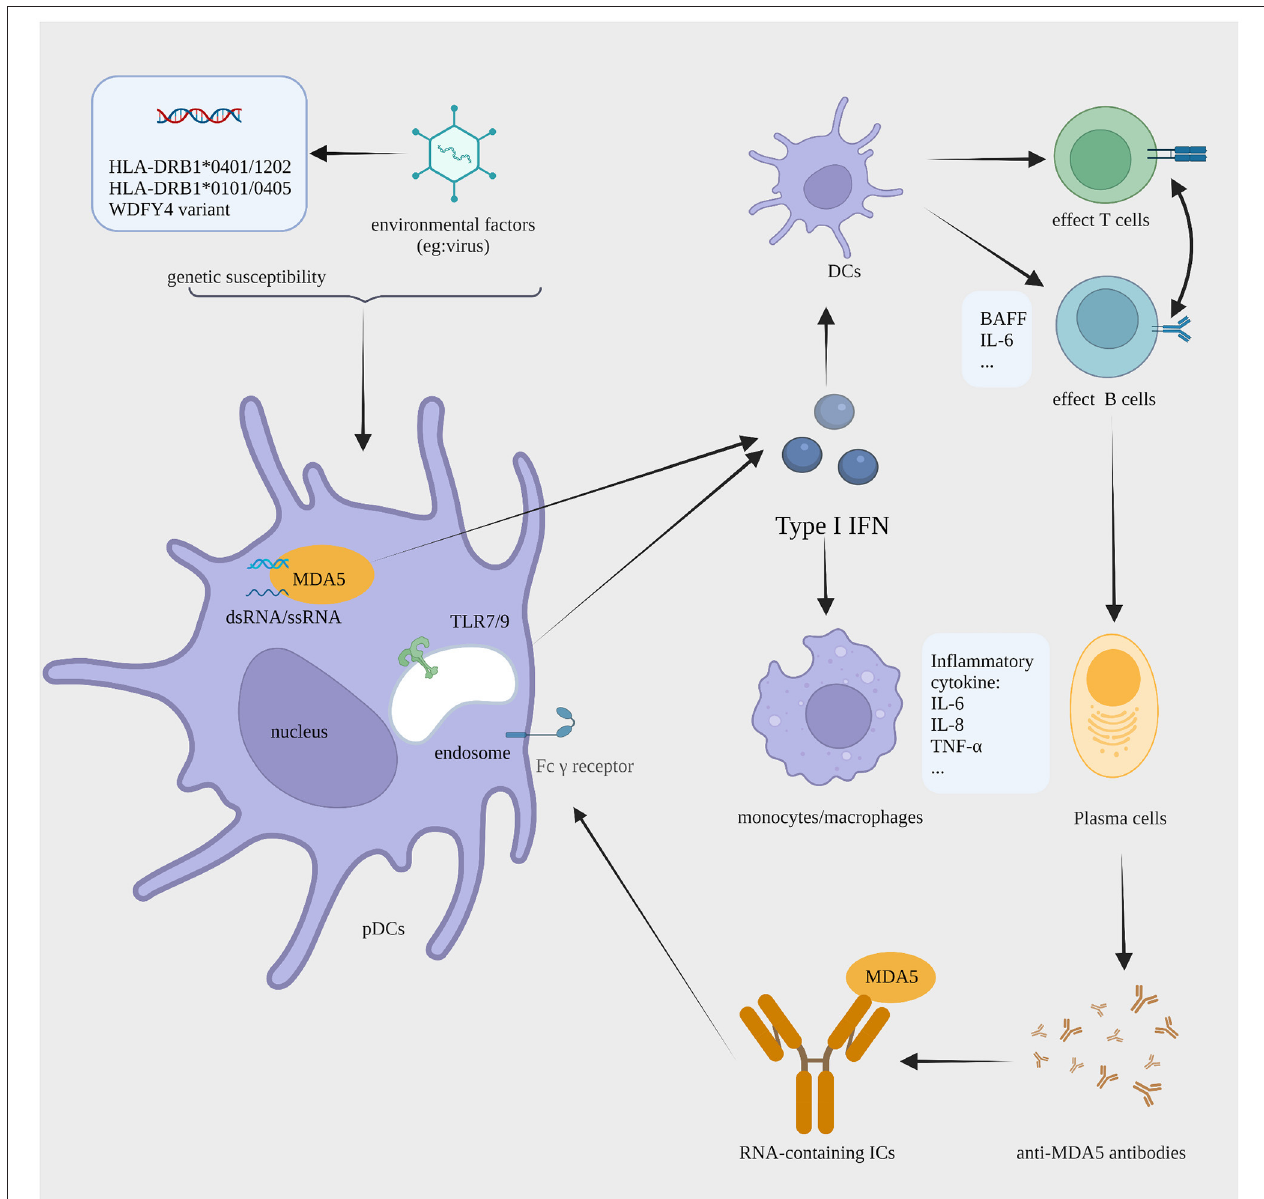
FIGURE 1 | The proposed IFN I-mediated cellular pathology in MDA5 + DM. In individuals with a background of susceptibility genes (HLA-DRB1*0101 and *0405, HLA-DRB1*0401 and *1202, or a variant in WDFY4), the dsRNA of unknown viral trigger is sensed by MDA5, causing the aberrant production of type I IFN by pDCs. Type I IFN enhances the antigen presentation of DCs, the effector function of T and B cells, and antibody production by plasma cells. Anti-MDA5 antibodies are generated in large amounts and then recognize MDA5, forming RNA-containing ICs. The ICs can activate type I IFN production via TLR7. All this promotes continued type I IFN production that sustains pathogenesis by a process with features of a vicious circle. Moreover, monocyte and macrophage may contribute to the development of RP-ILD. IFN, interferon; MDA5 + DM, anti-melanoma differentiation-associated gene 5 antibody-positive dermatomyositis; pDCs, plasmacytoid dendritic cells; DCs, dendritic cells; ICs, immune complexes; TLR, toll-like receptor; RP-ILD, rapid progressive interstitial lung disease. The figure is created with